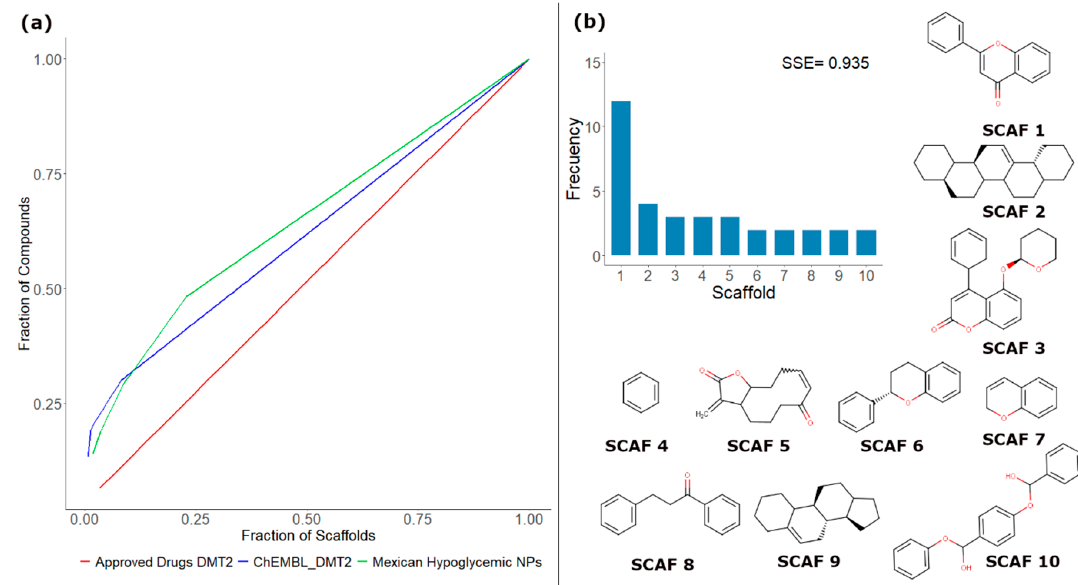
Figure 2. ( a ) Cyclic system retrieval (CSR) curves for three different libraries: natural products (NPs) isolated from Mexican hypoglycemic plants [32] (green), drugs approved to treat diabetes mellitus type 2 (DMT2) (red), and compounds evaluated to treat DMT2 deposited in the ChEMBL (blue); ( b ) Distribution and Shannon entropy for the 10 most frequent chemotypes in active NPs isolated from Mexican hypoglycemic plants.